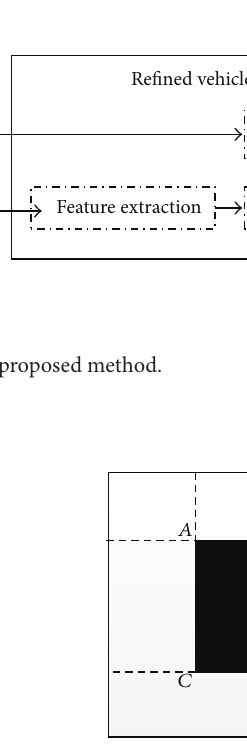
Figure 2: Integral